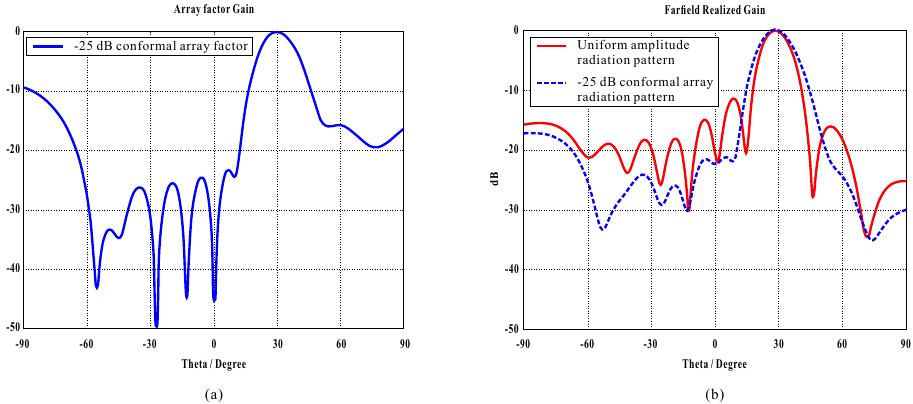
Figure 14. Comparison of 8 × 8 random-grid amplitude-tapering 2D radiation patterns: ( a ) array factor of conformal array calculated with MATLAB, ( b ) comparison of simulated radiation patterns for uniform and amplitude tapering